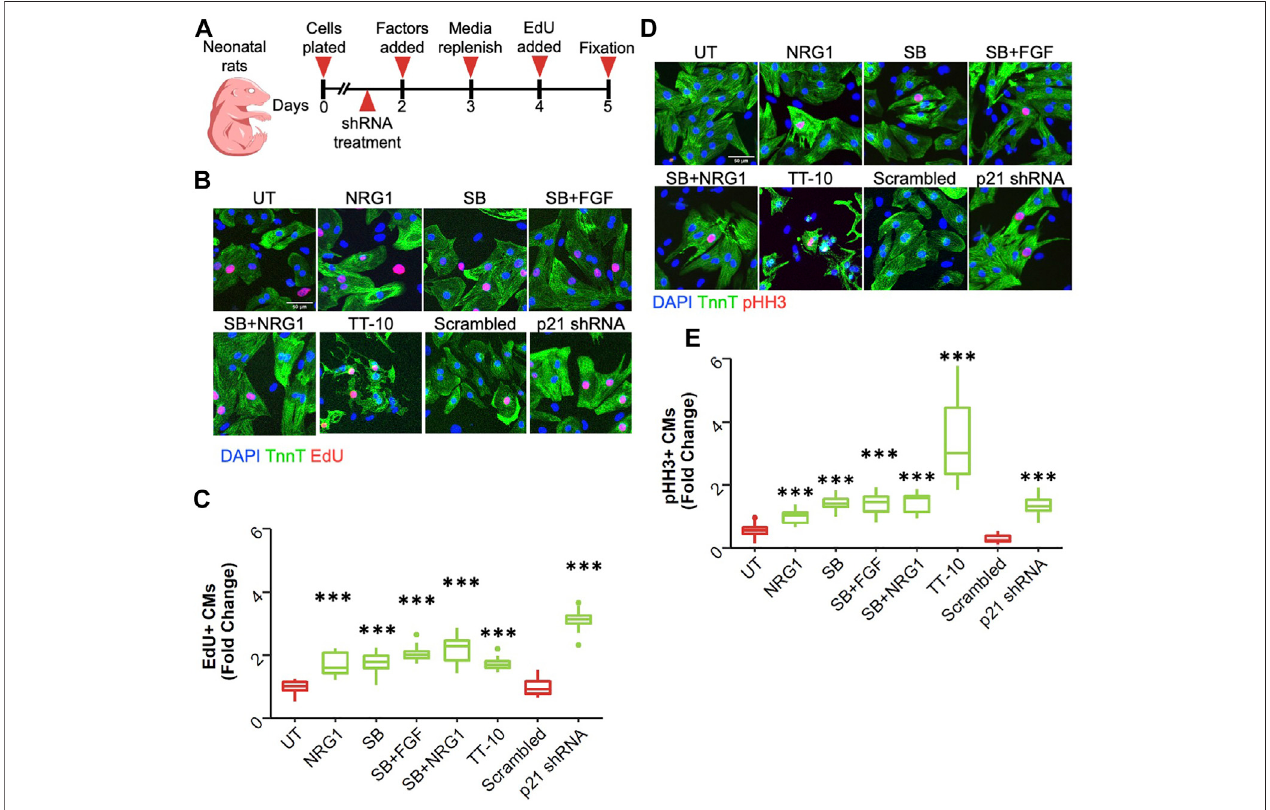
FIGURE 1 | Stimulation of cardiomyocyte DNA synthesis. (A) Graphical overview of experimental outline. shRNAs are p21shRNA or scrambled shRNA adenoviruses. Other conditions are growth factors that were added on Day 2. (B) Representative images of EdU stained (red) cardiomyocytes (green) in response to various treatments to induce cardiomyocyte proliferation (green: Troponin T, red: EdU, blue: DAPI, scale bar equals 50 µm) (C) Percentage of EdU positive cardiomyocyte nuclei relative to total cardiomyocyte nuclei. *** p < 0.001 vs respective controls, n = 12 for each group except p21 shRNA ( n = 11) and TT-10 ( n = 10). (D) Representative images of pHH3 staining (green: Troponin T, red: pHH3, blue: DAPI, scale bar equals 50 µm) (E) Percentage of pHH3-positive cardiomyocyte nuclei relative to total cardiomyocyte nuclei. *** p < 0.001 vs respective control, n = 12 for each group except p21 shRNA ( n = 11) and TT-10 ( n =